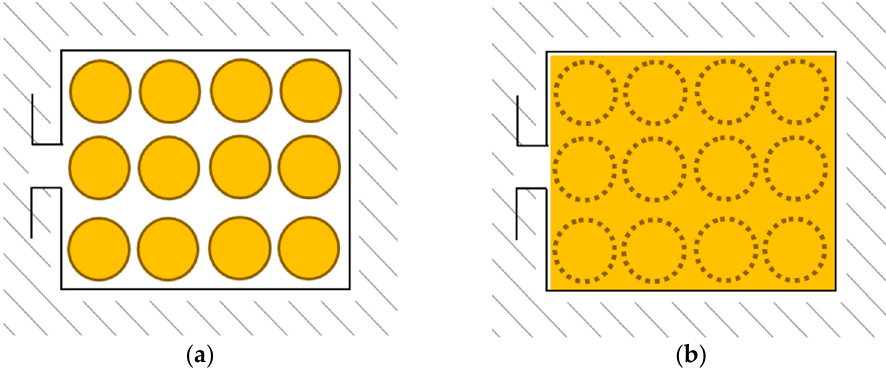
Figure 2. ( a ) Slot filled with real conductors used for DFEA model; ( b ) equivalent slot uniformly filled with conductor material and virtually placed conductors used for SFEA model.